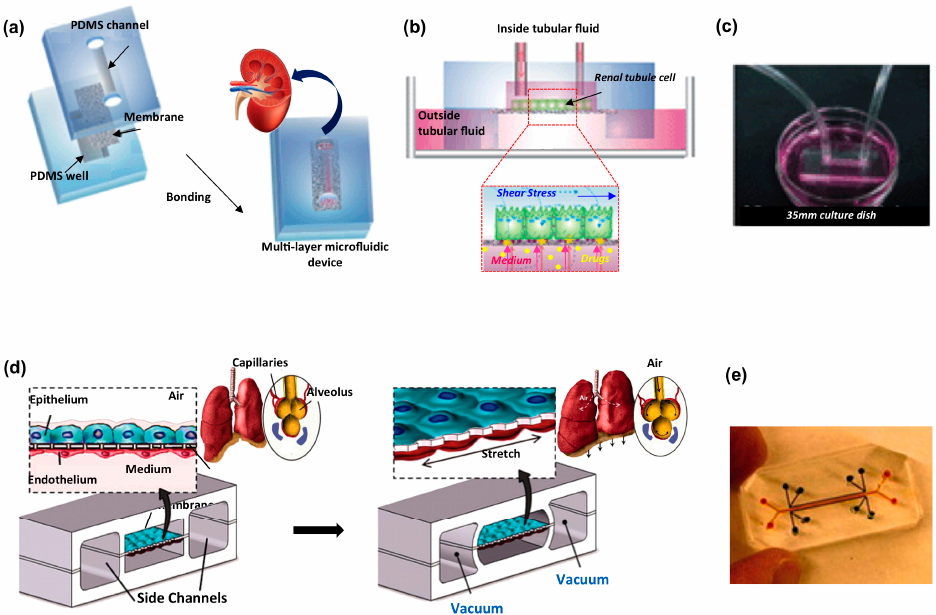
Figure 3. Biological barrier microfluidic models applied for kidney and lung organs. Kidney platform: ( a ) sketch of the fabrication process involving the sandwich assembly of the porous membrane between two PDMS layers; ( b ) schematic of the chip operating principle; and ( c ) picture of the device connected to a syringe pump through silicon tubing. Adapted from [137] with permission. Human lung on a chip: ( d ) schematic of the epithelial and endothelial cells co-cultured on opposite sides of the porous membrane, stretched applying vacuum in the side channels to mimic alveolar deformation during normal breathing; and ( e ) picture of a microdevice filled with color dyes. Adapted from [121] with permission.